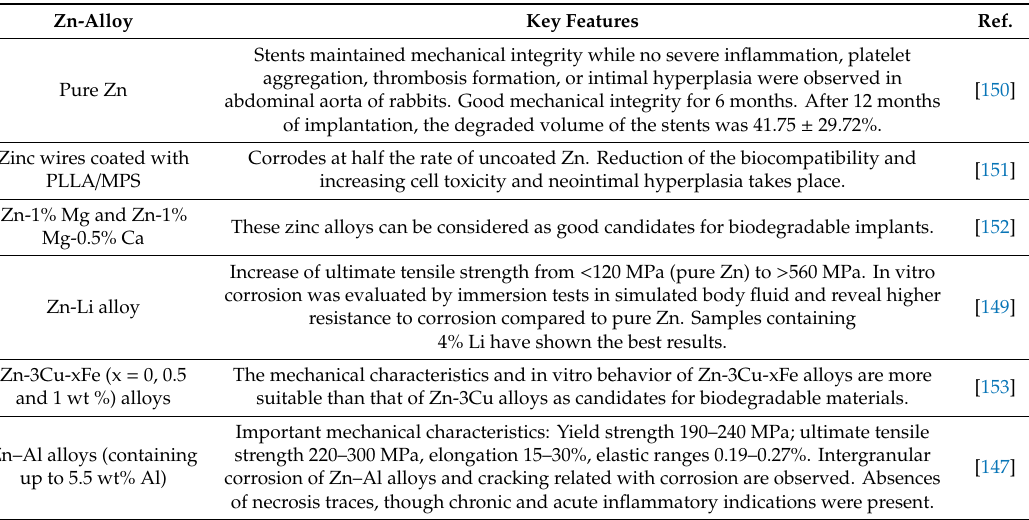
Table 2. Zn alloys used for stent